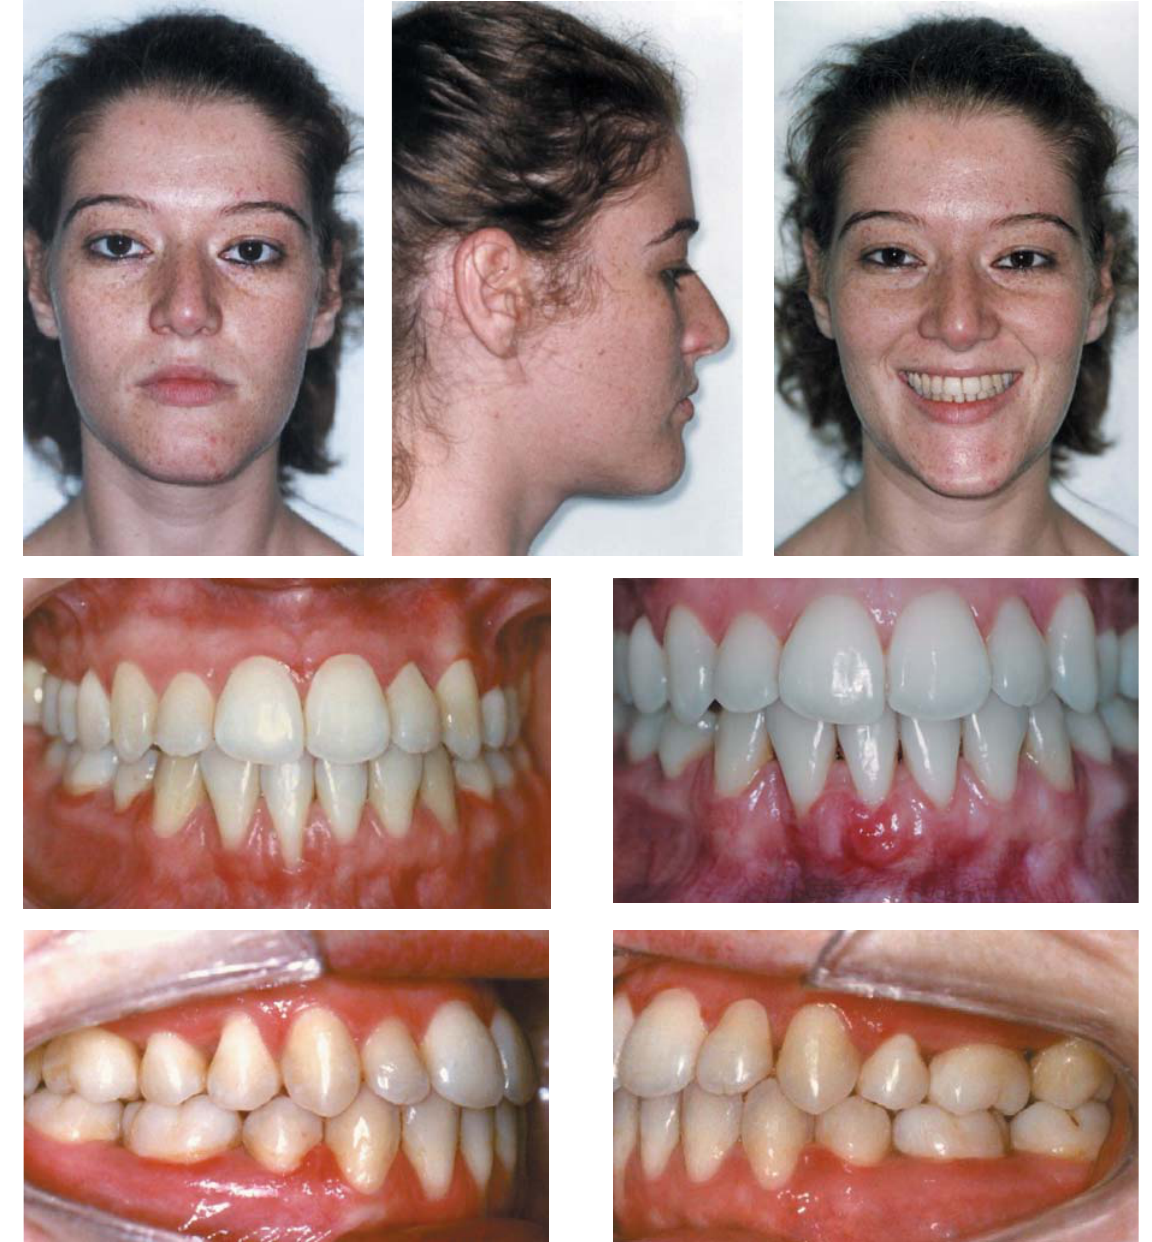
FIGURE 6- Posttreatment facial and intraoral photographs. A functional canine Class I occlusion with good overbite and overjet was achieved. The intraoral frontal photograph on the right shows the periodontal surgery at the mandibular right central incisor, a few days after the procedure (patient signed informed consent authorizing the publication of these